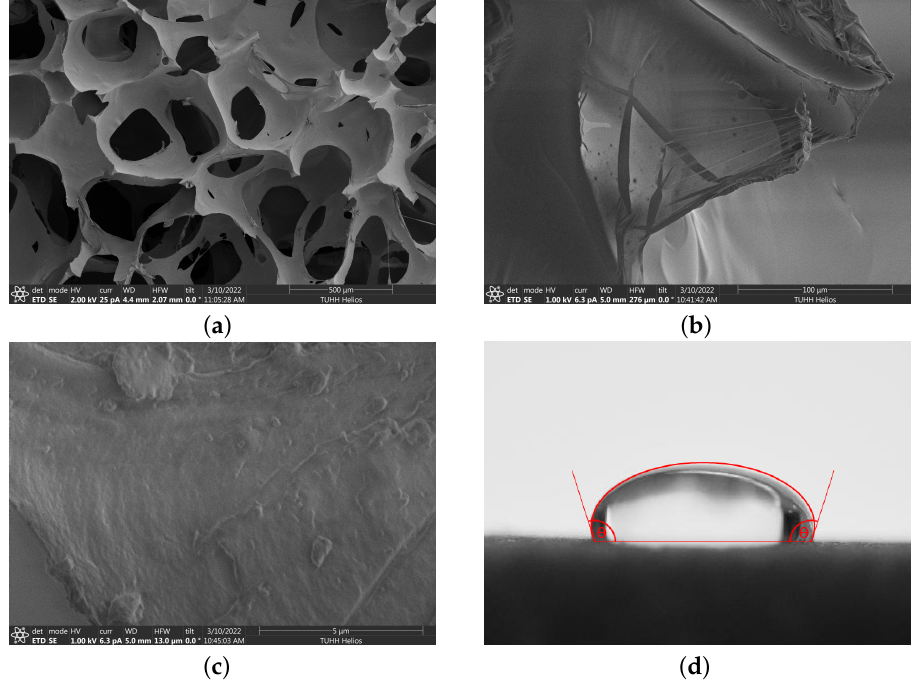
Figure 1. Scanning electron microscope images of the RMPUF at different magnifications and horizontal field widths (HFW) as ( a ) HFW = 2075 µm, ( b ) HFW = 276 µm, and ( c ) HFW = 13 µm. Dimensional scaling is marked in the respective images. ( d ) Optical measurement of the wetting angle θ ≥ ( 95 ± 3 ) ◦ between ASW and the